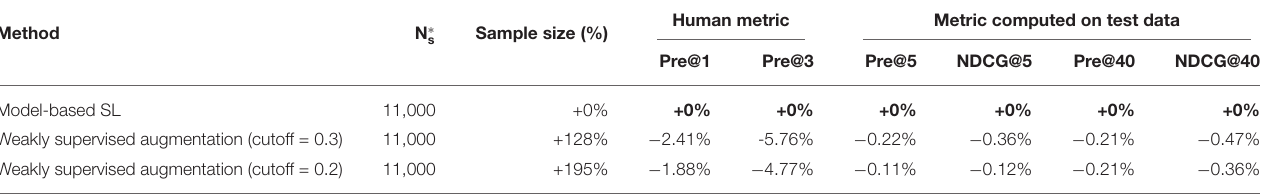
TABLE A1 | Summarization of shortlister models’ performance with weakly supervised data augmentation. Normalized relative difference of each method when compared to baseline method “model-based SL” is presented. Positive values (+) implies that the method outperforms baseline method.